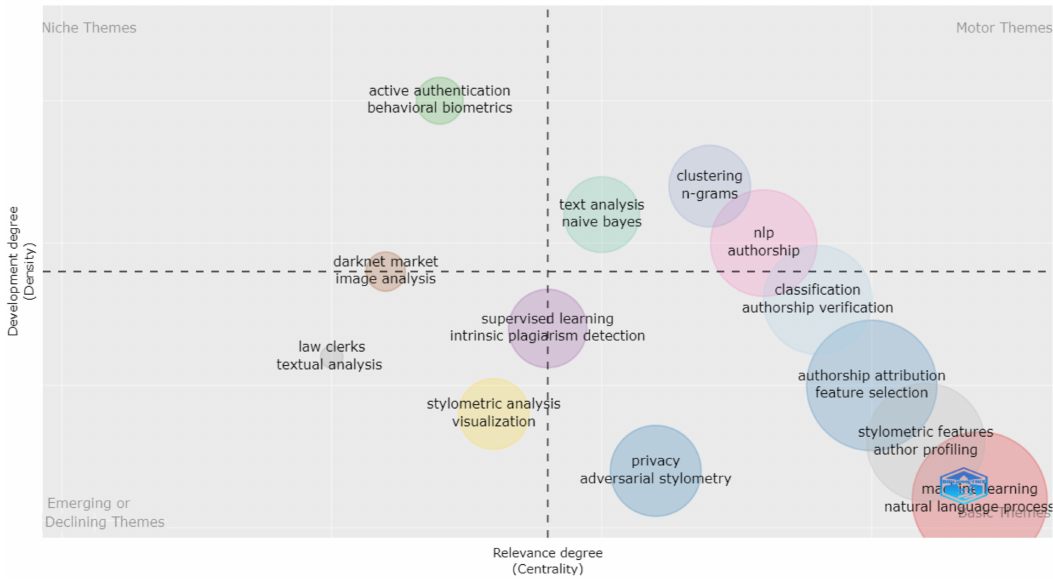
Figure 12. Thematic map for Period 3 (2007–2021) (this map was generated by